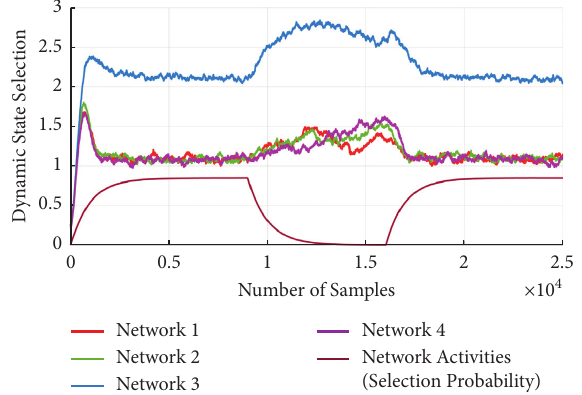
Figure 10: Effect of threshold on network connectivity for � 9 ) . sensitivity � 5 ( V thrl